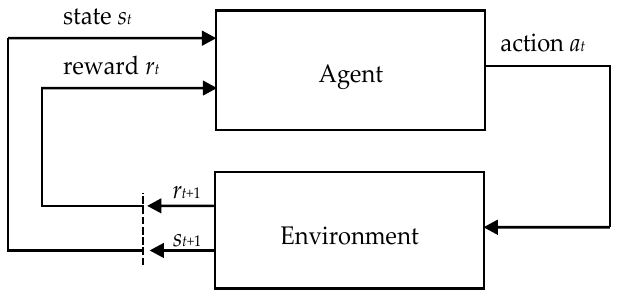
Figure 1. Agent – environment interaction loop in reinforcement learning. Figure 1. Agent–environment interaction loop in reinforcement